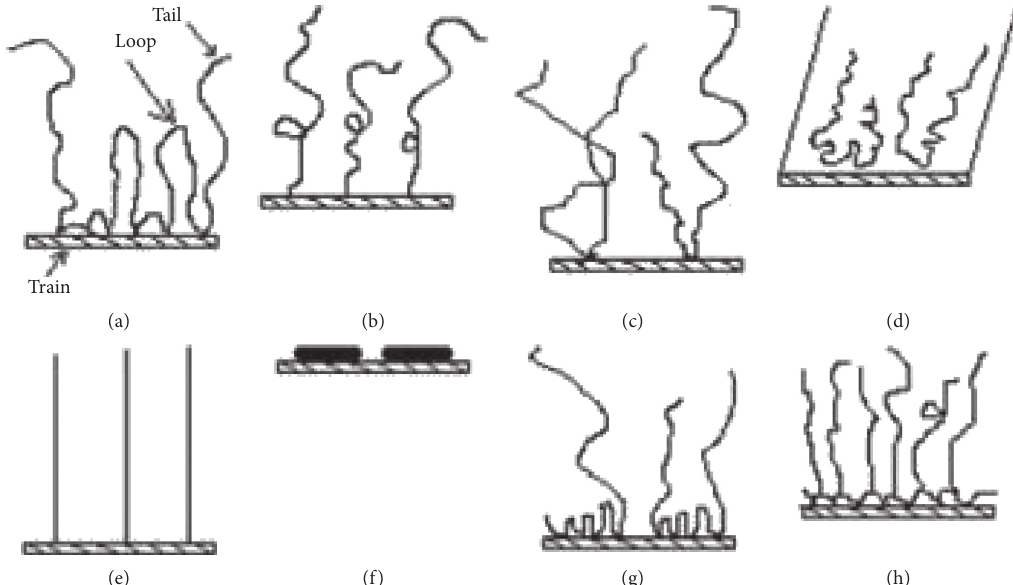
Figure 1: Various action forms of PCE (main chains): (a) homopolymer effect (ring-shaped, serial, and caudate), (b) end-effector effect (caudate), (c) role effect (2 caudate), (d) flat-like effect, (e) vertical effect of rigid chain, (f) lying adsorption of rigid chain, (g) effect of block copolymer, and (h) tooth effect of graft